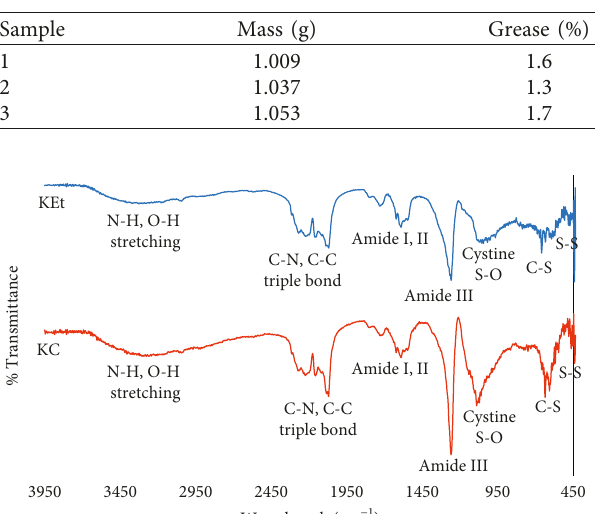
Figure 2: Stages of the experiment. Table 1: Feather grease percentages.